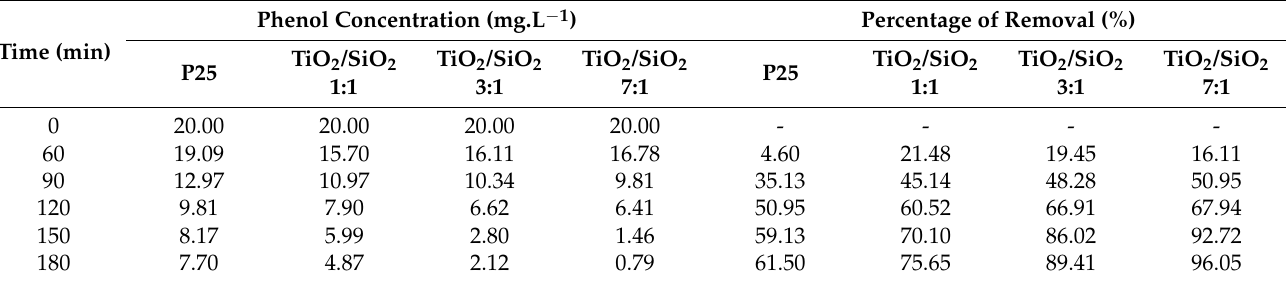
Table 9. Concentration and percentage of phenol removal over